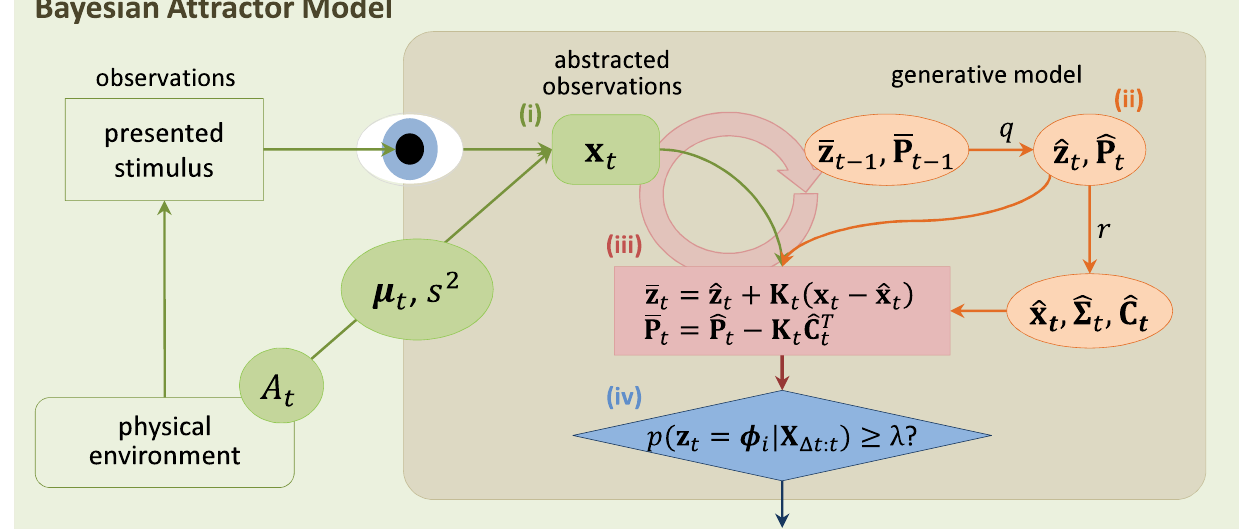
Fig 3. Illustration of the inference scheme used for decision making in the BAttM. In the physical environment a stimulus is presented by the experimenter and observed by the subject. Components inside the shaded rectangle model internal processes of the subject. Sensory processes in the subject ’ s brain translate the stimulus into an abstract feature representation x t . The input model (i, green) of the BAttM approximates this translation by mapping the stimulus identity (decision alternative A t at time t ) to a value x t drawn from a Gaussian distribution with mean μ t and covariance s 2 I . The generative model (ii, orange) states that the decision state z is represented by a Gaussian N ð (cid:2) z The generative model further maps the decision state to different Gaussian densities over observations which mirror those in the input process (Eq 3). Consequently, for the next time step, the generative model predicts the distribution of the decision state, N ð ^ z ; b Σ Þ , which critically depend on model parameters q and r , respectively. The cross-covariance between predicted decision state and predicted N ð ^ x t t b C observation is denominated . Bayesian inference (iii, red) iteratively compares observations x t with predictions ^ x t state (Eq 4) via the Kalman gain K t which processes the uncertainty de fi ned by explicit measure of con fi dence (Eq 6).